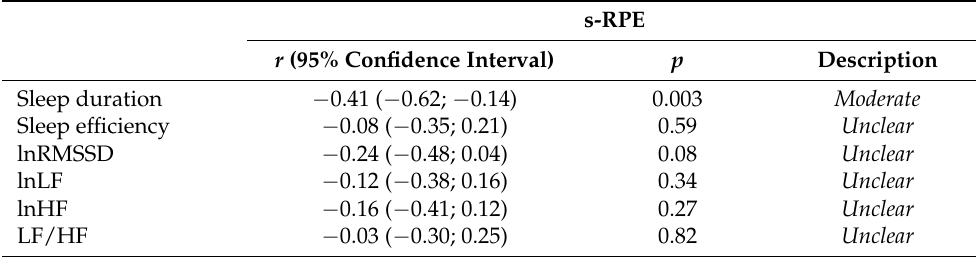
Table 3. Within-subject correlation between sleep indices and nocturnal cardiac autonomic activity with session-rating of perceived exertion (s-RPE) during the 5-day tournament (n =